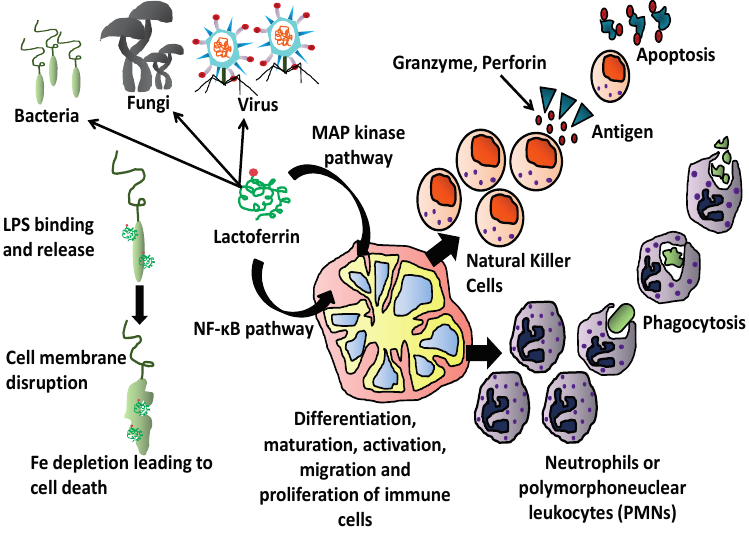
Figure 2. Role of lactoferrin in the activation of immune cells. Lactoferrin modulates the differentiation, maturation, activation, migration, proliferation and function of immune cells. It also promotes the cell-cell interaction and activation of PMNs and NK cells, thus boosting the immune response